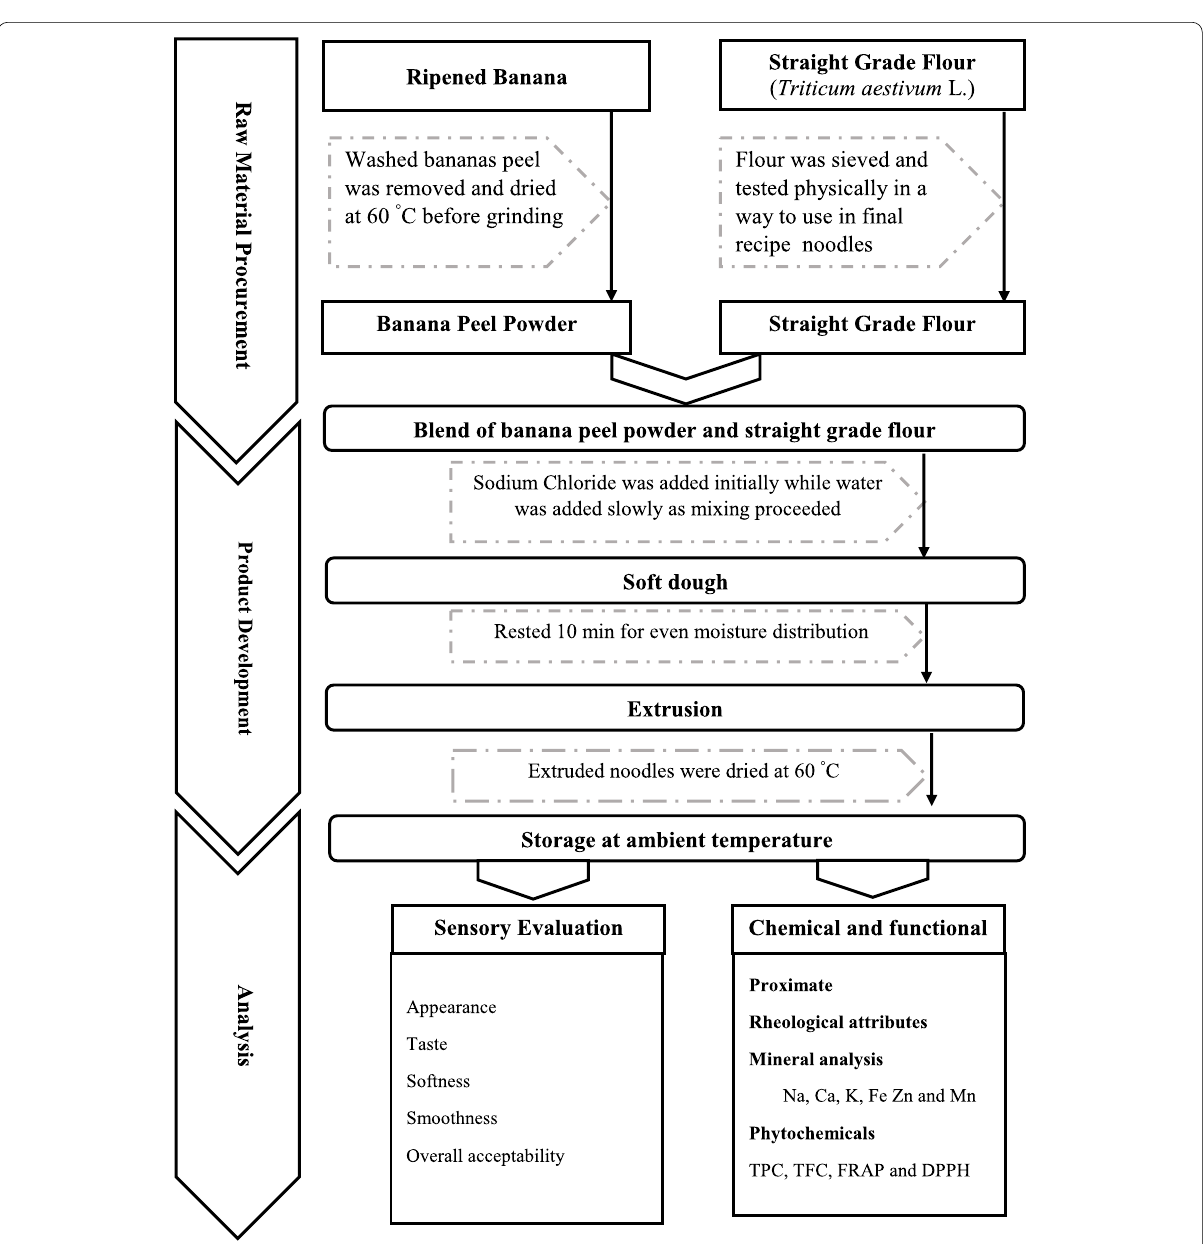
Fig. 1 Flow line of study showing important